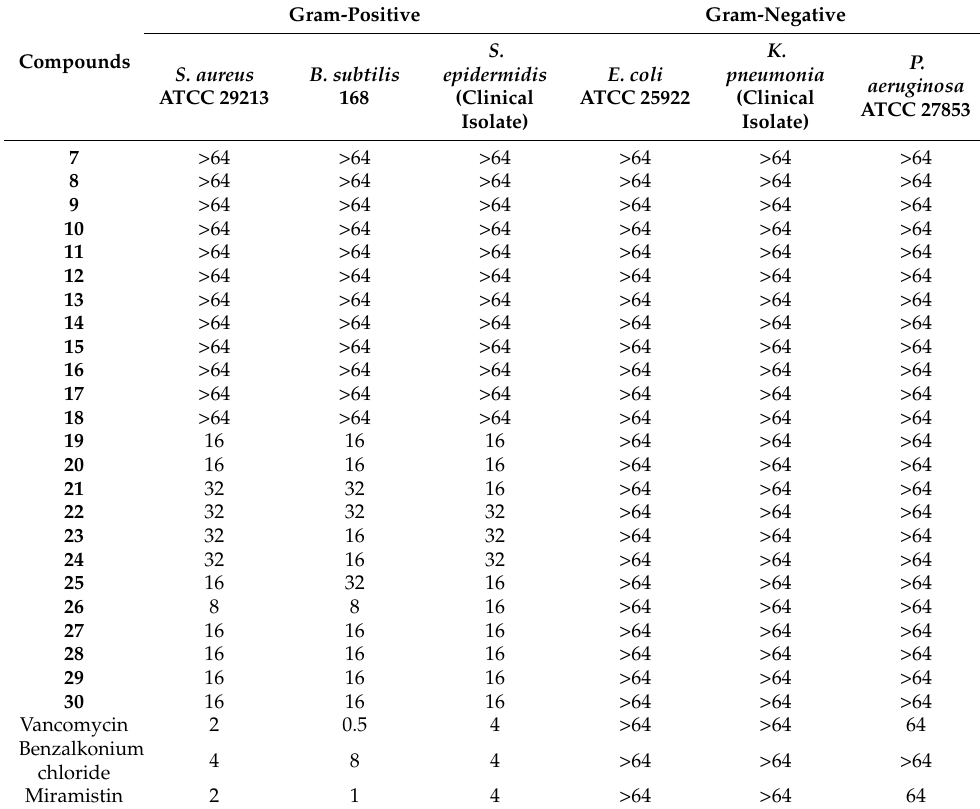
Table 1. In vitro antimicrobial activity of 2(5 H )-furanone derivatives 7 – 30 and reference drugs (MICs, µ g/mL). The median values from five independent experiments are shown.